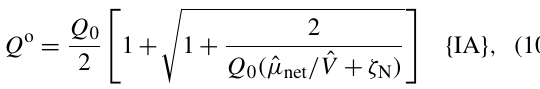
Mortality rate coefficient Hydrolysis rate constant Remineralization rate